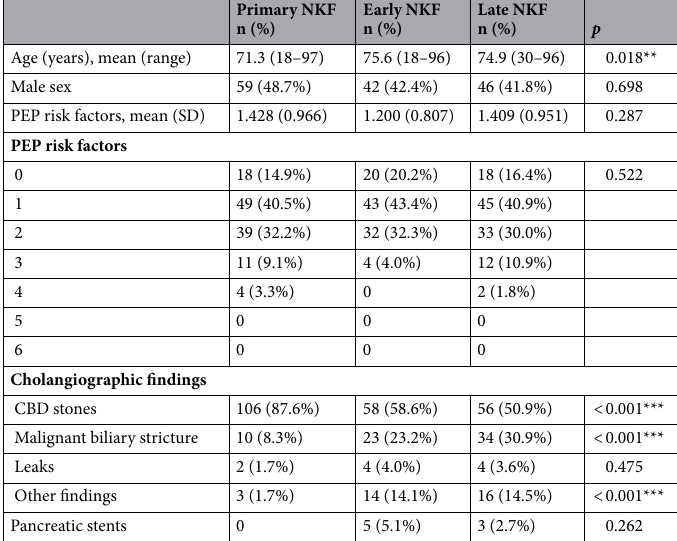
Table 1. Patient demographics, patient-related factors for PEP, use of pancreatic stents and cholangiographic findings for the 3 NFK groups. ** p < 0.05. *** p < 0.01.